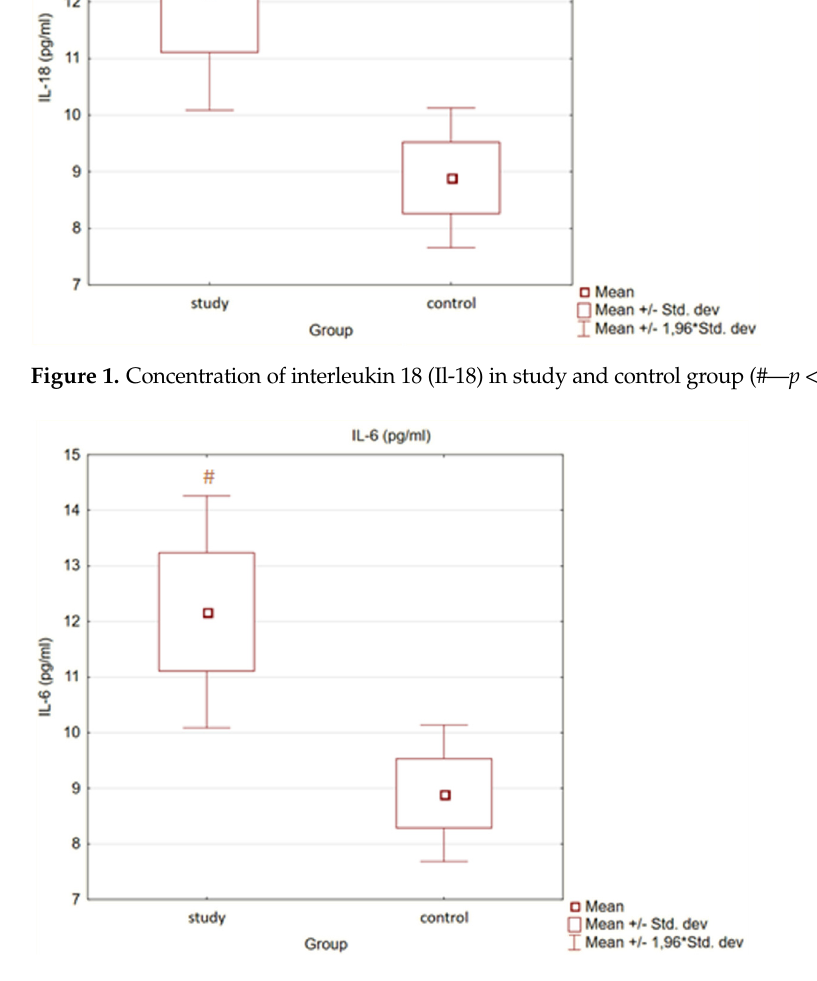
Figure 2. Concentration of interleukin 6 (Il ‐ 6) in study and control group (#— p < 0.05 versus control).